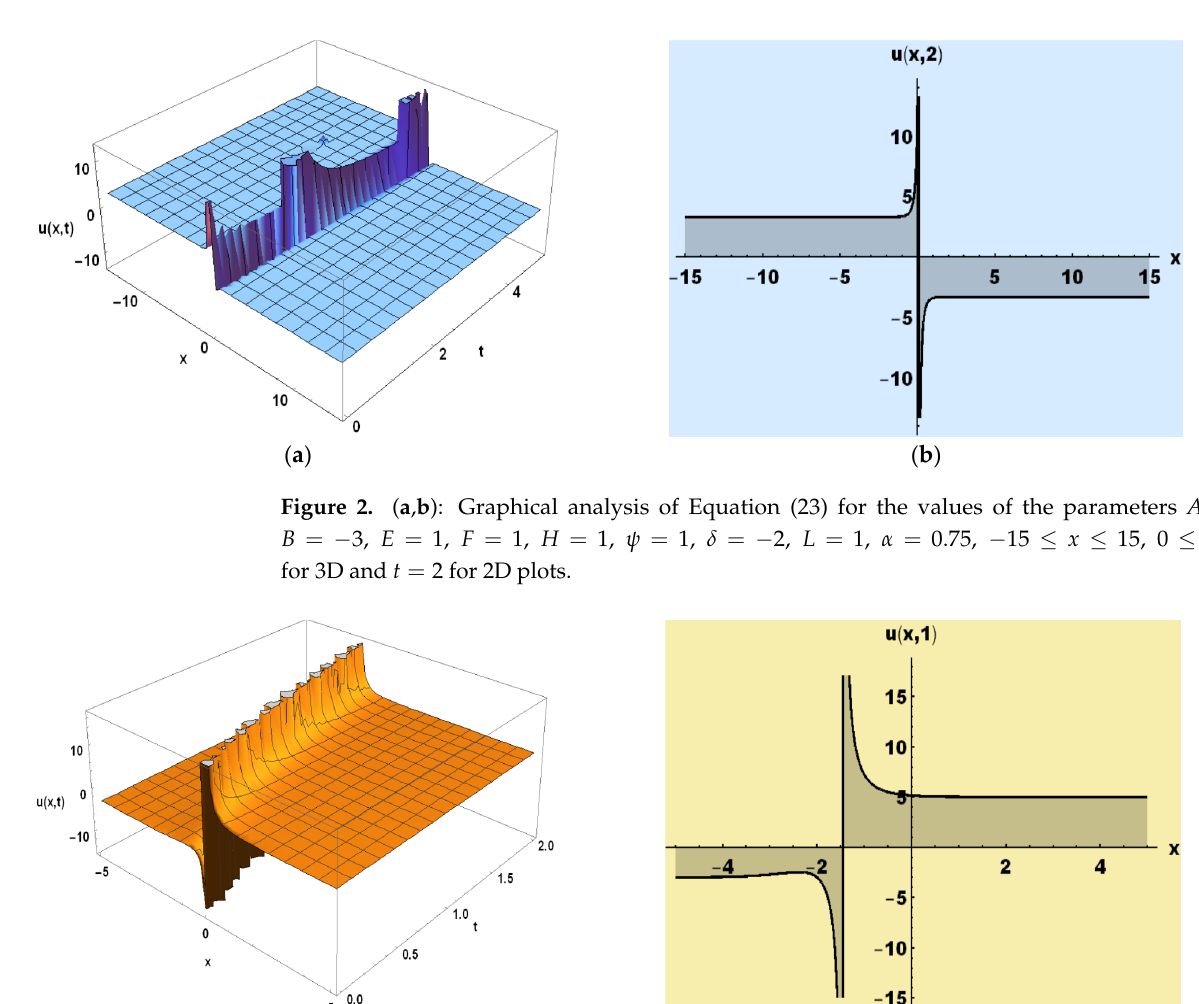
Figure 1. ( a , b ): Graphical analysis of Equation (19) for the values of the parameters ,1,1,1,2 FEBA ,10,55,75.0,1,1,1,1 txLH for 3D and 2.0 t for 2D plots.